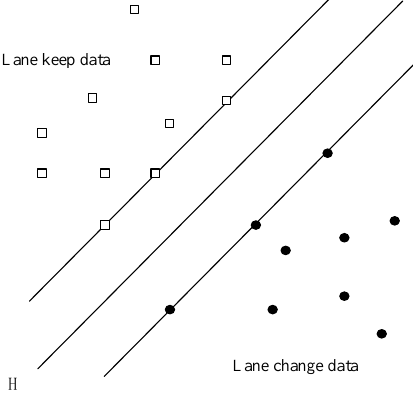
Figure 4. Schematic diagram of connected unintelligent vehicle (CUV) data classification.